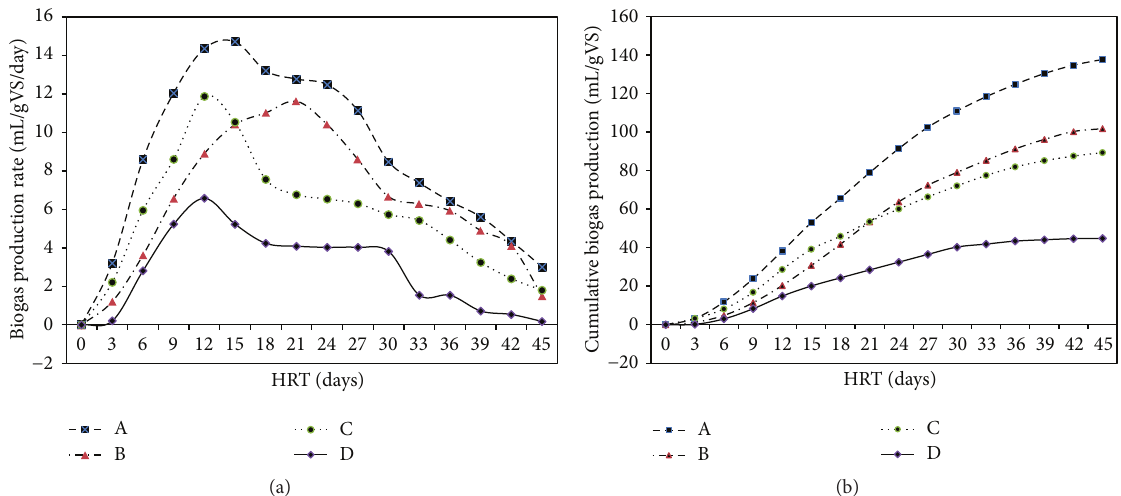
Figure 5: (a) Biogas production rate of thermally treated (A and B), untreated (C) biomass and inoculum (D) for a retention time of 45 days. (b) Cumulative biogas production of thermally treated (groups A and B), untreated (group C) biomass and inoculum (group D) for a retention time of 45 days.